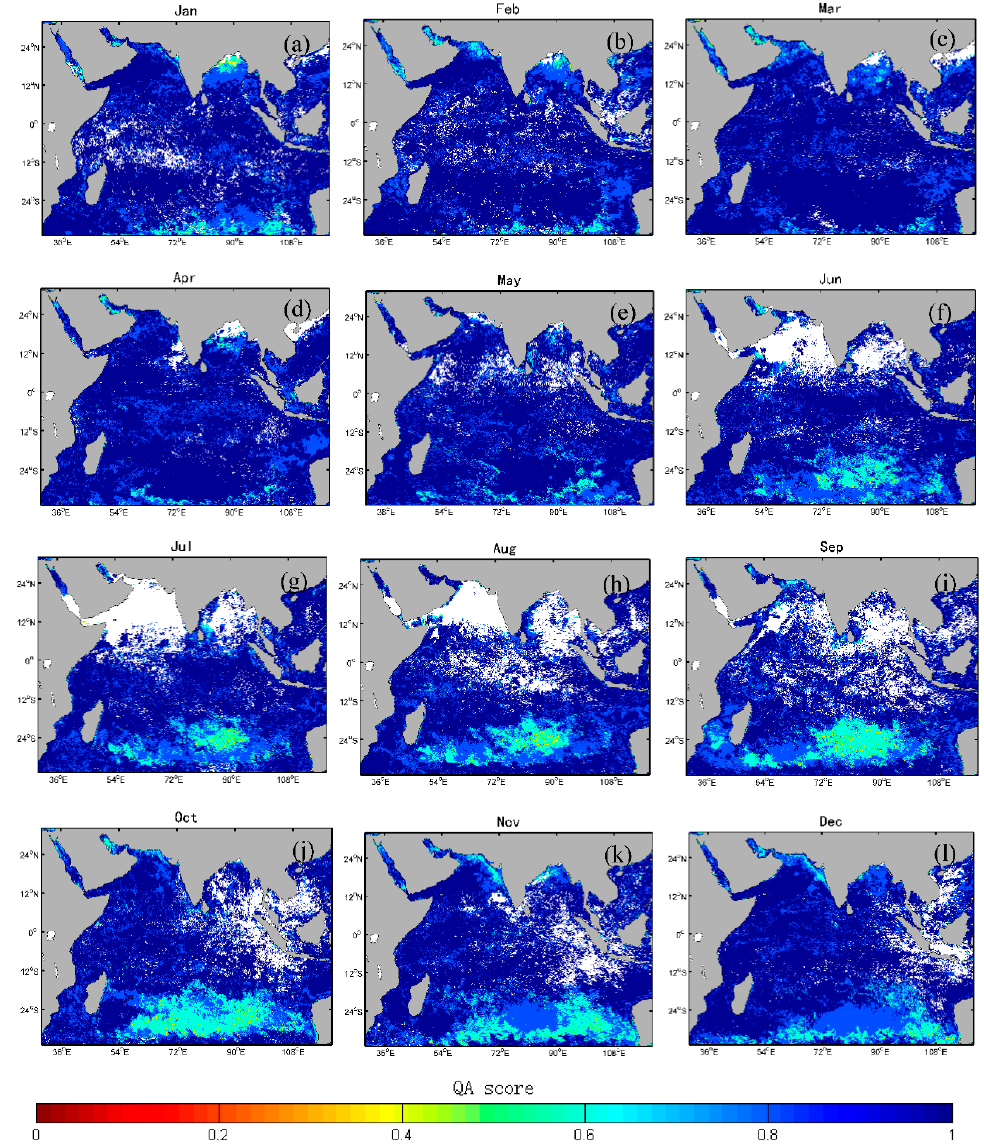
Figure 9. QA Scores of VIIRS–NPP level 3 R rs ( λ ) monthly products from January ( a ) to December ( l ) in 2016 in the IO. The white color represents invalid pixels.